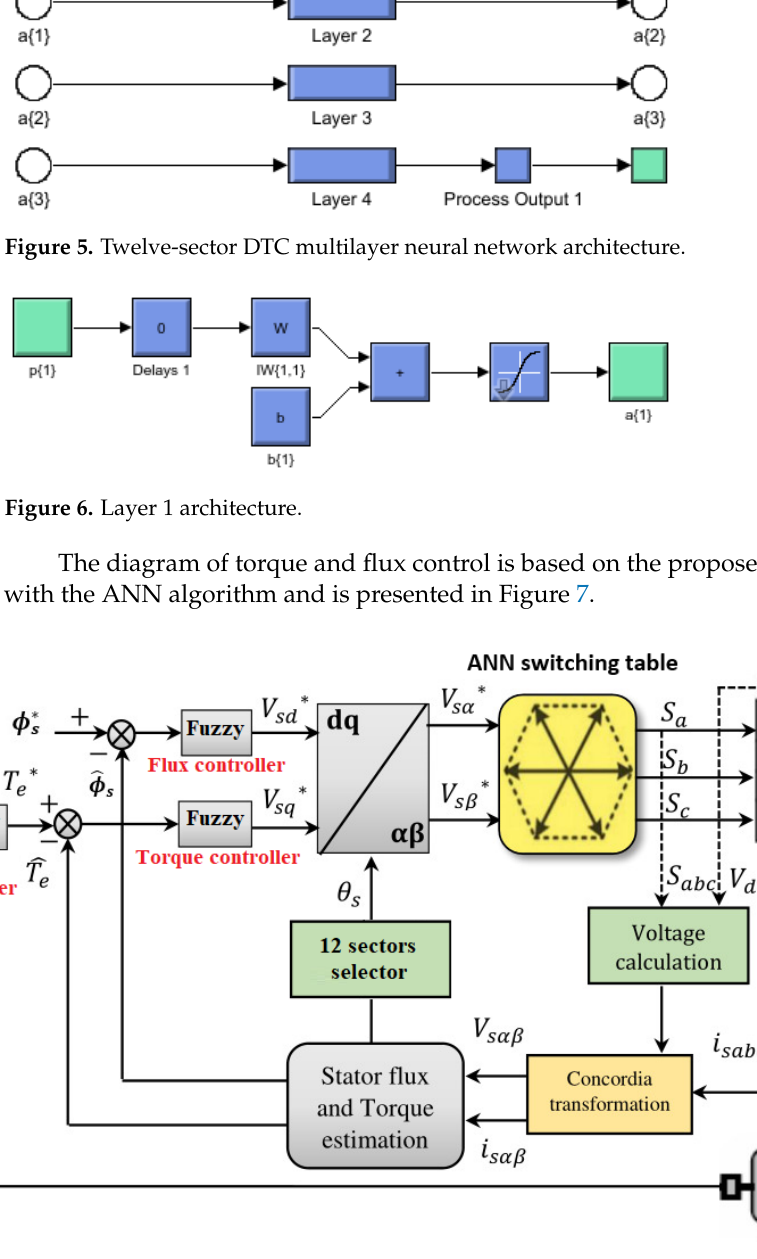
Figure 7. The proposed control scheme. The asterisk ∗ designates the reference quantities. The speed controller generates the reference torque, while the flux and torque con- trollers generate the d - q voltage components. The NN switching table generates the inverter control states. In the DTC scheme, there is no need for a PWM modulator, nor the coordi- nates’ transformation. The twelve-sector selector generates the suitable angle for the ANN switching